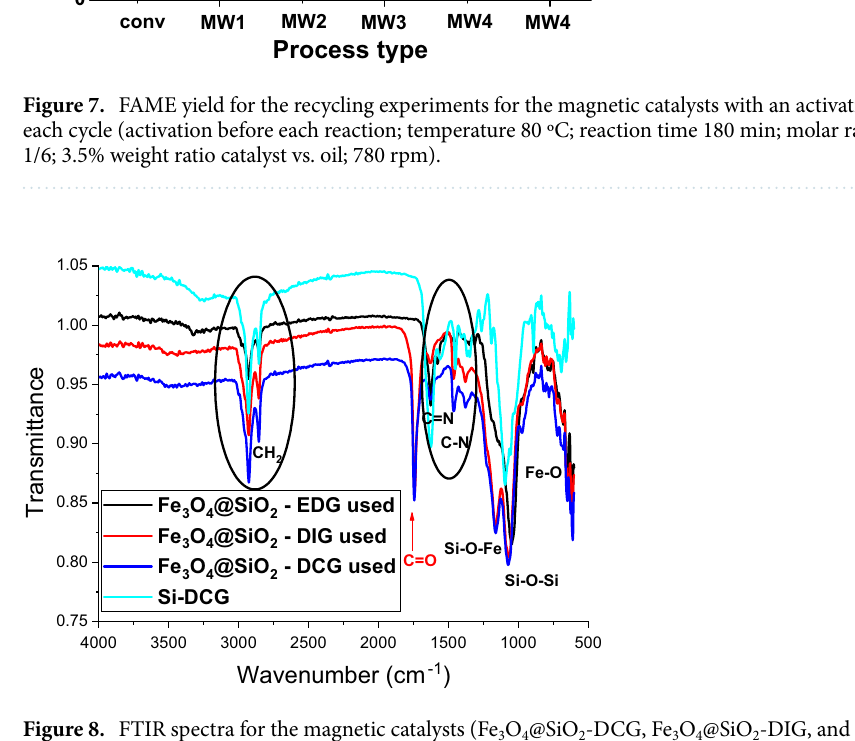
Figure 8. FTIR spectra for the magnetic catalysts (Fe 3 O 4 @SiO 2 -DCG, Fe 3 O 4 @SiO 2 -DIG, and Fe 3 O 4 @SiO 2 - EDG) after the reaction and before the re-activation